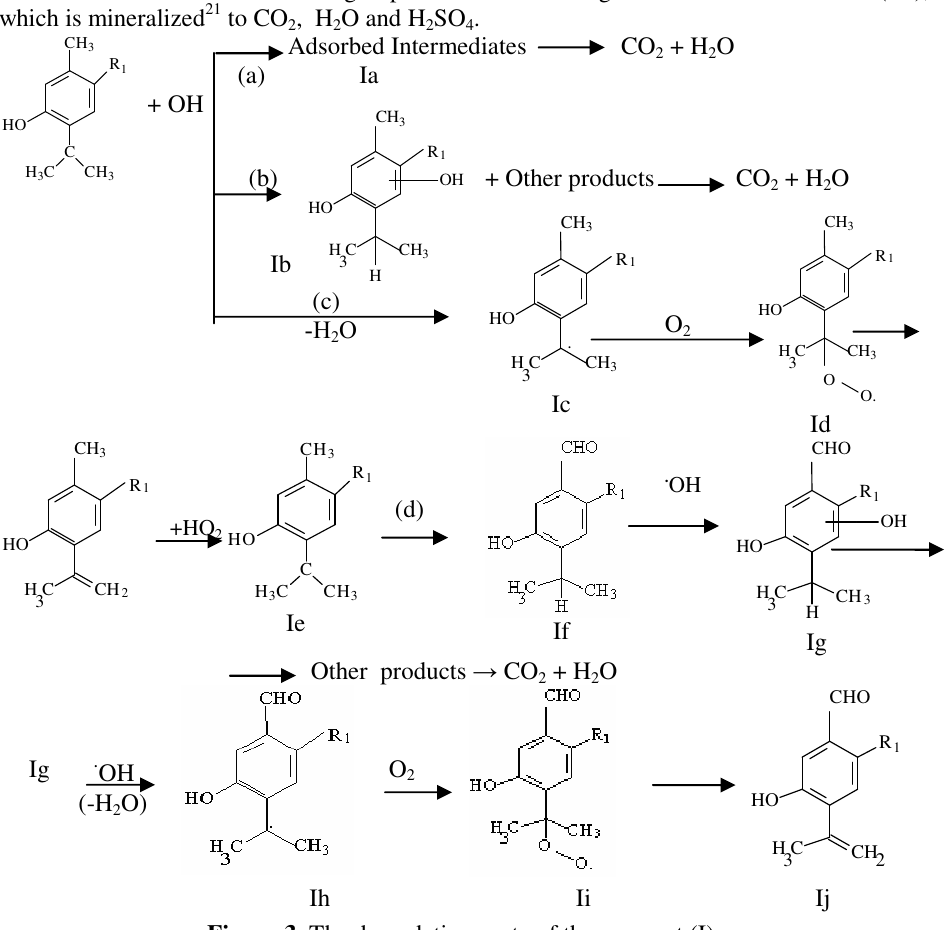
Figure 3 . The degradation route of the segment